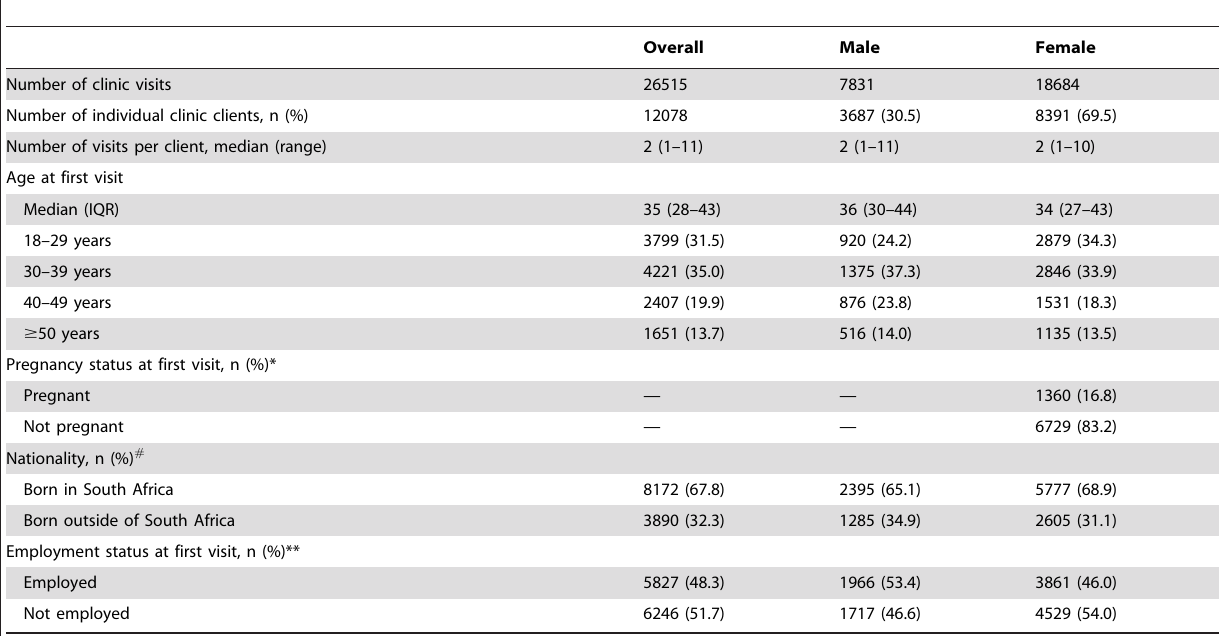
Table 1. Characteristics of clients seeking care at a primary care clinic in Johannesburg, South